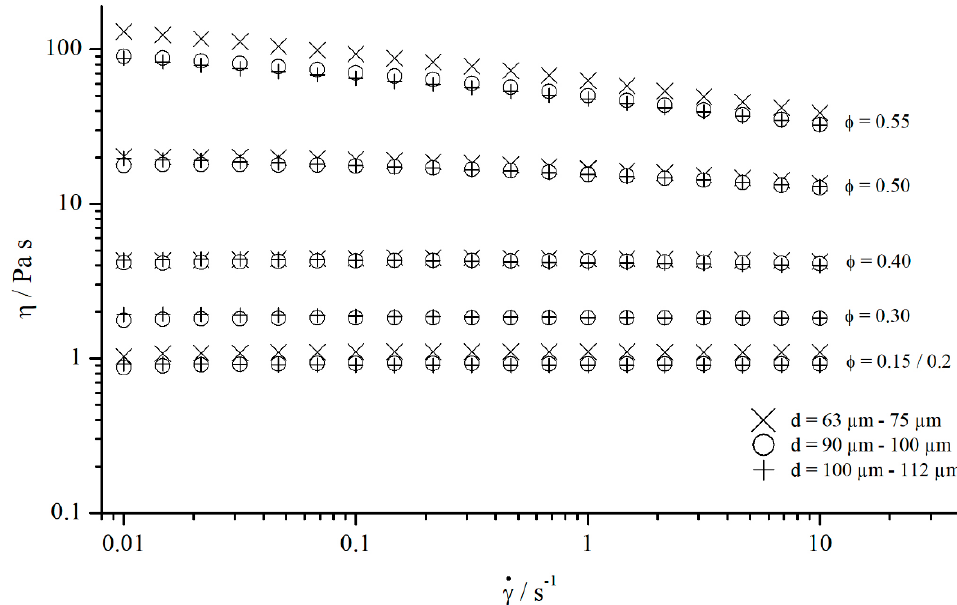
Figure 23. Flow curves of suspensions containing different particle volume fractions ф .